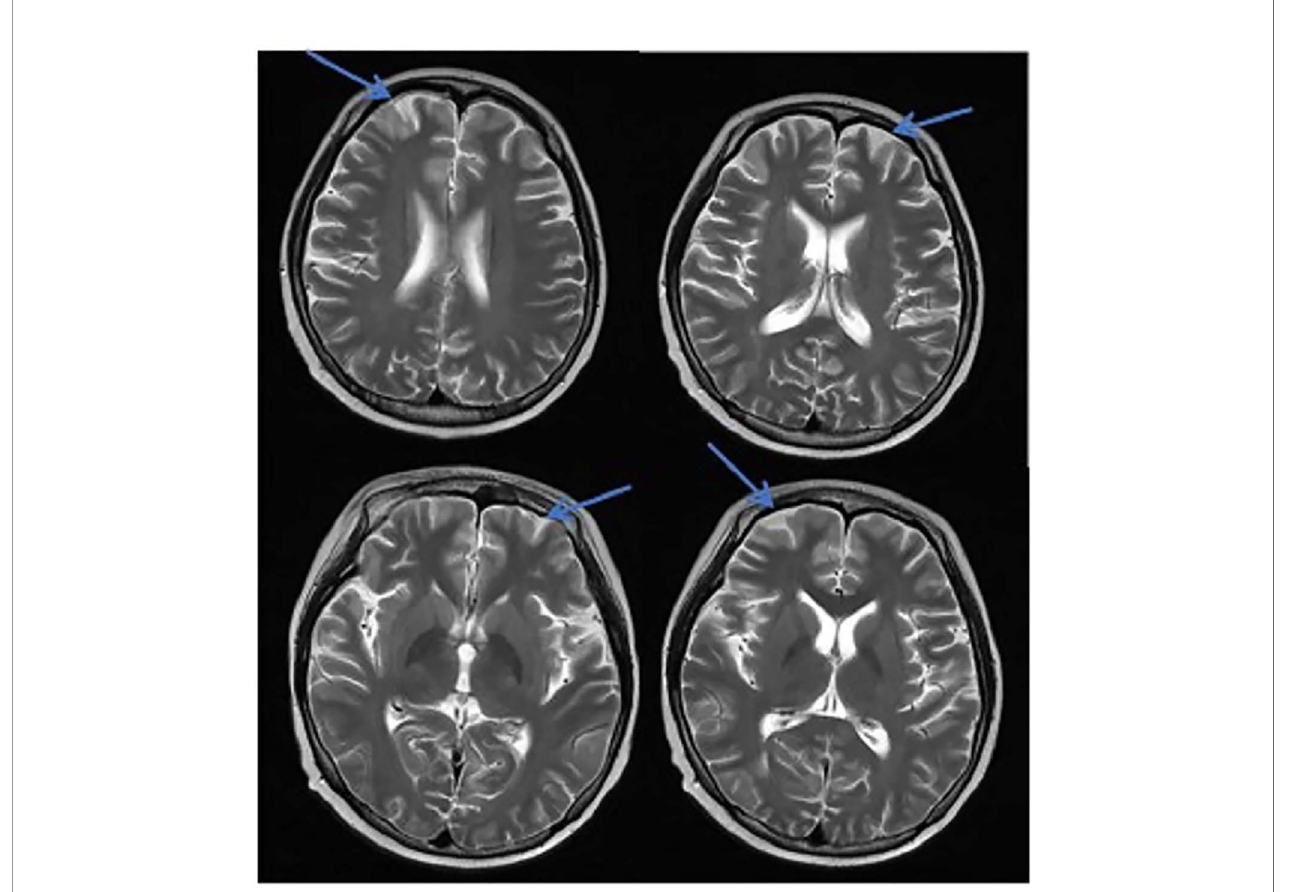
FIGURE 3 | MRI in patients with CNS infection. The CNS infection showed fl air hyperintensity in the cerebral cortex, but no clear display on the T2WI, T1WI, DWI, and no enhancement after